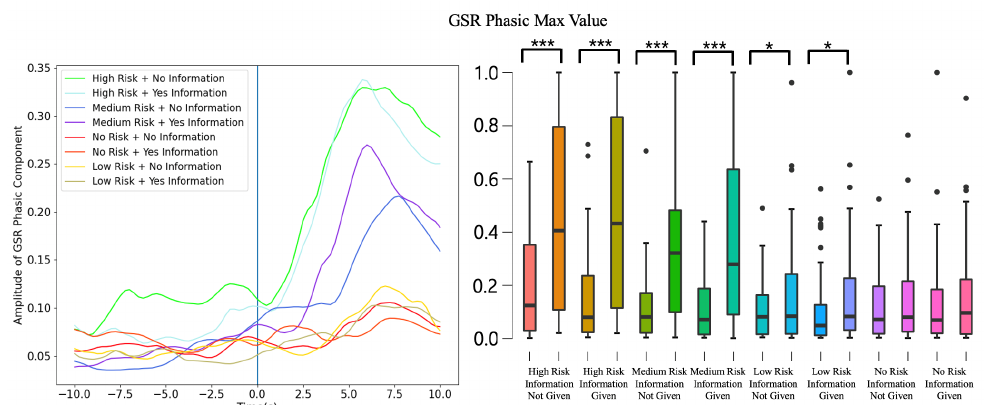
Figure 6. Left: Average values across all subjects for GSR phasic data from 10 s before and after the event for the eight scenarios. Right: A graph comparing GSR phasic data before and after the event. The use of asterisks in the figure indicates statistical significance. A single asterisk (*) denotes a p -value less than 0.05, while three (***) asterisks denote p -values less than 0.001,